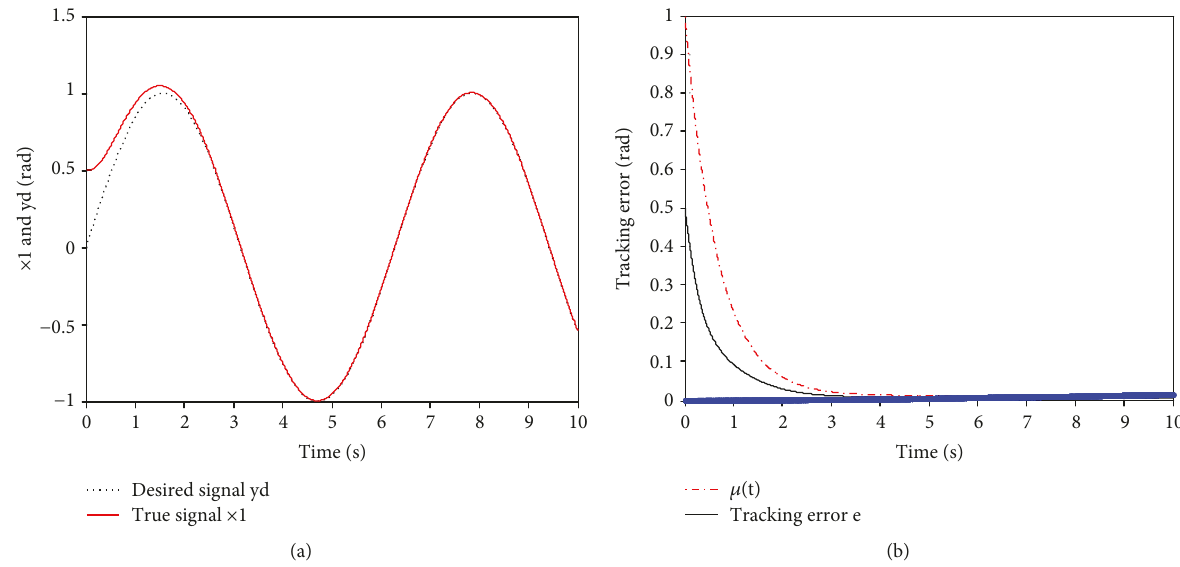
= 0 01 , δ = 0 5 , γ = 10 , and η = 5 : ∞